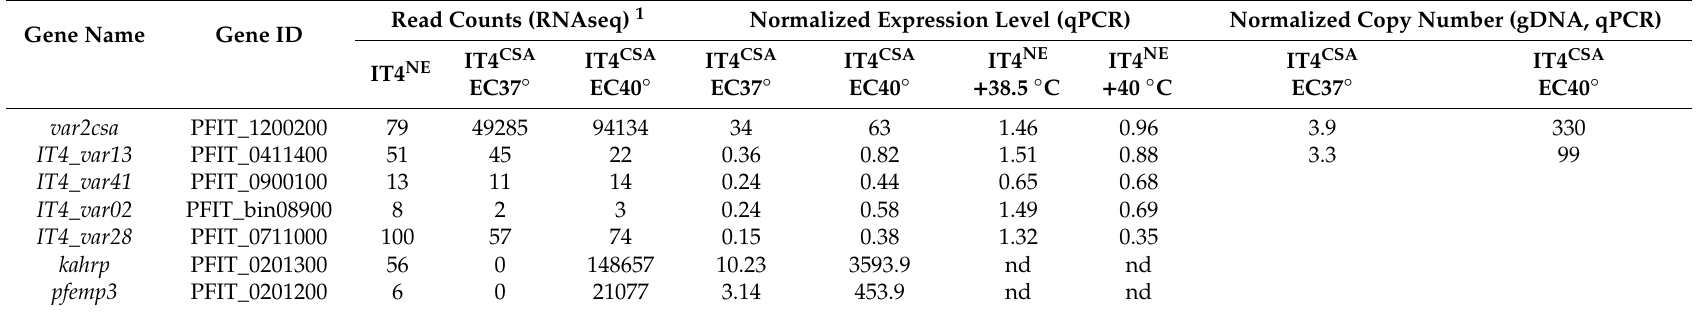
Table 1. Read counts of RNAseq analysis and normalized expression level determined using qPCR for selected genes of IT4 CSA EC37 ◦ , IT4 CSA EC40 ◦ , and IT4